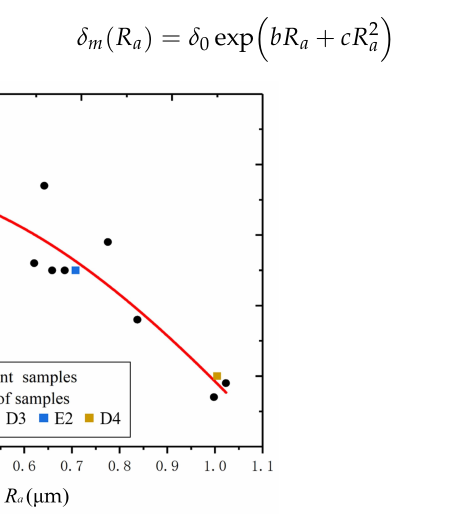
Figure 7. The correlation between δ m and R a values for 100 nm gold samples under different schemes. Table 4. The additional experimental data of R a and their corresponding SEY values. R a ( µ m)